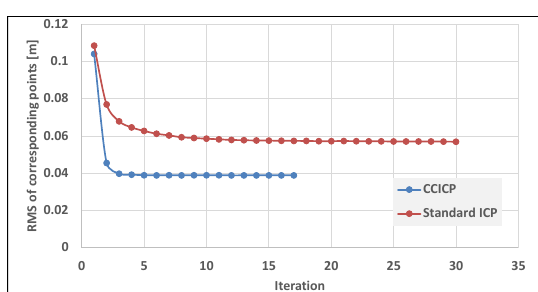
Figure 10. Comparing RMS values at each